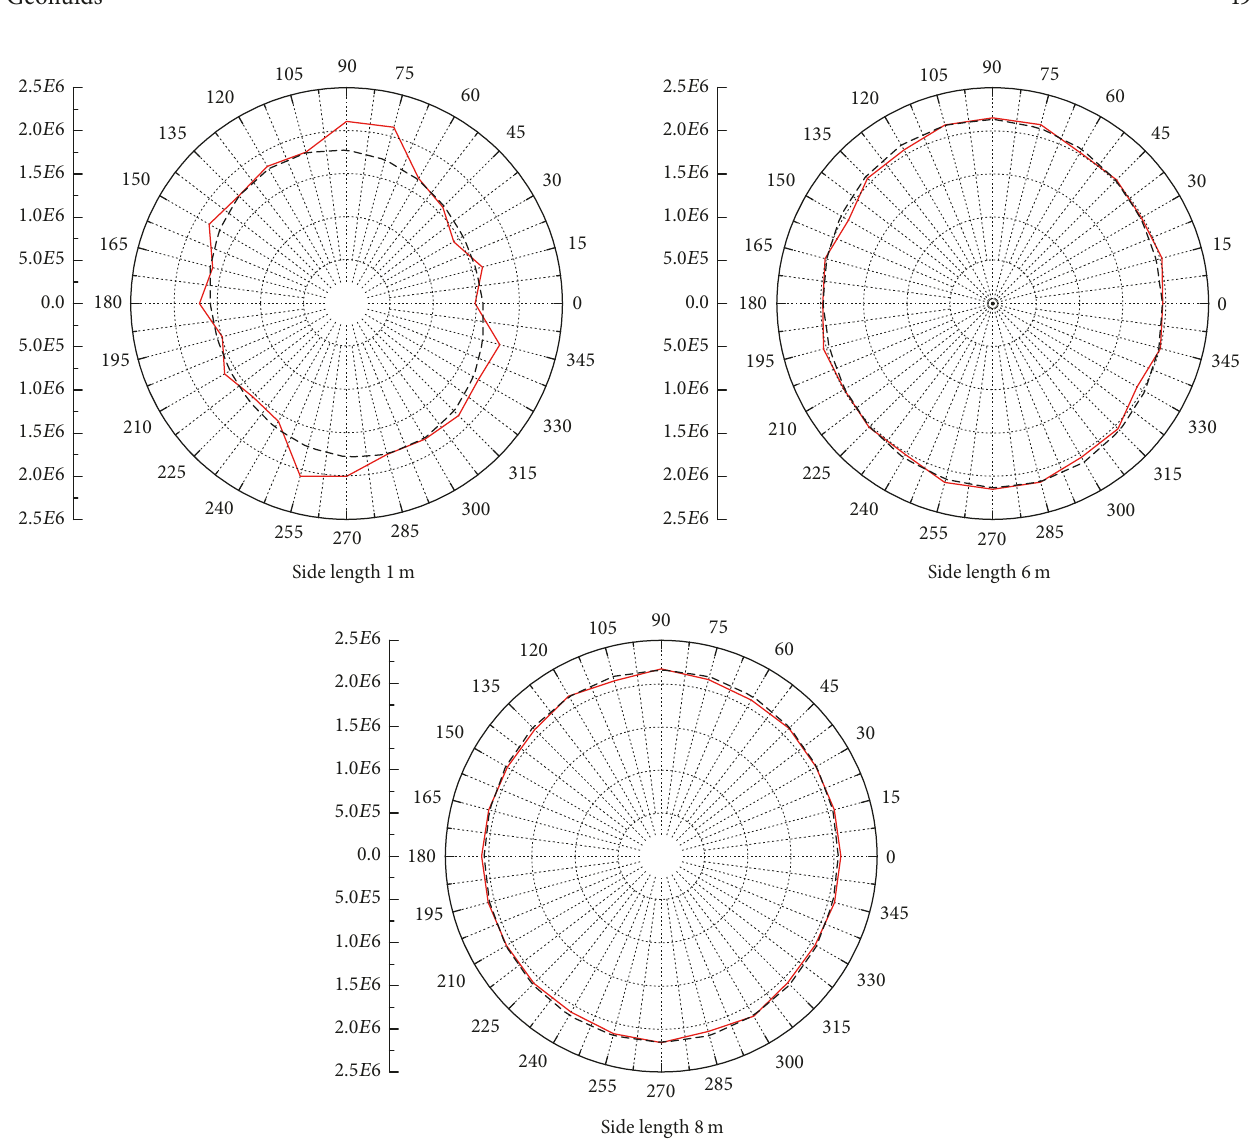
found. For example, the REV of the non-Darcy flow is inconsistent with the REV of the Darcy flow, and the REV of the non-Darcy flow is larger than the REV of the Darcy